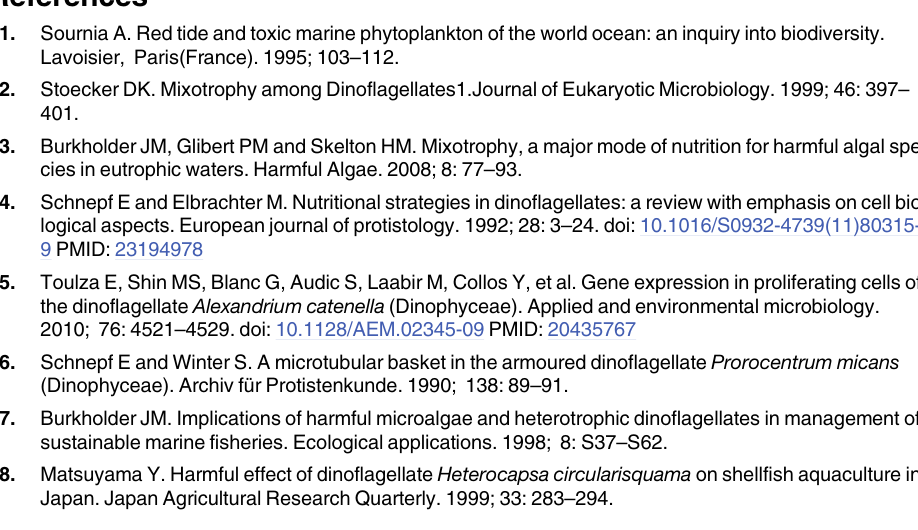
S15 Fig. Secondary structures of aca- miR190576-3p. S1 Table. Species range and species priority information. All the aligned species in the miR- Base and their priority are listed. Chlamydomonas reinhardii (cre) was the preferentially aligned species. S2 Table. Specific forward primers used in this experiment. The specific forward primersof